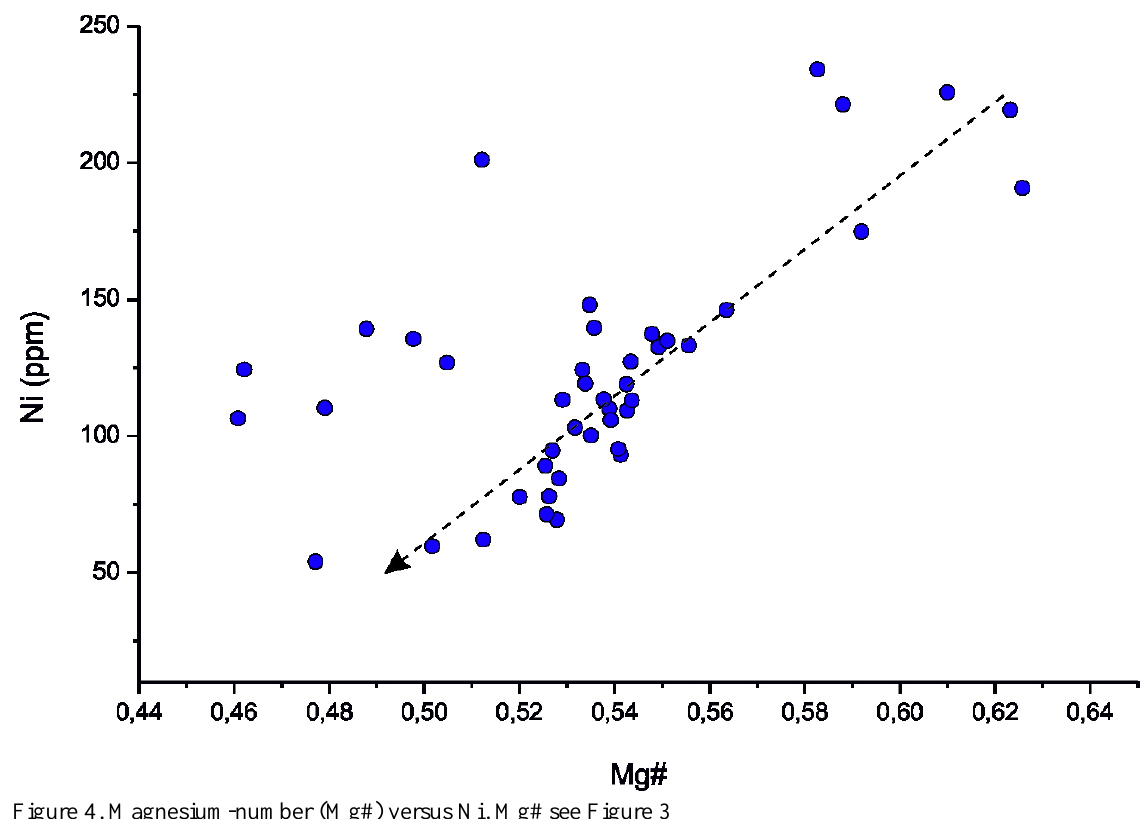
Figure 4. Magnesium-number (Mg#) versus Ni. Mg# see Figure 3